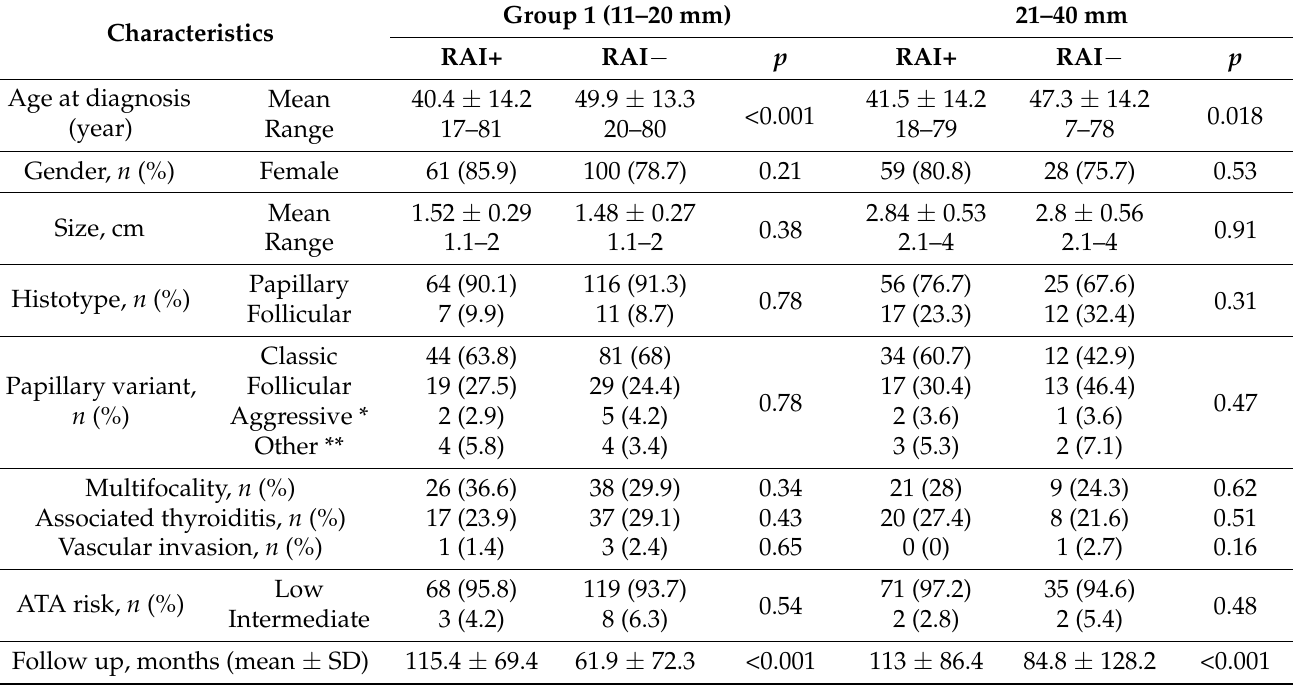
Table 1. Baseline histopathological and clinical characteristics of the 2 groups of